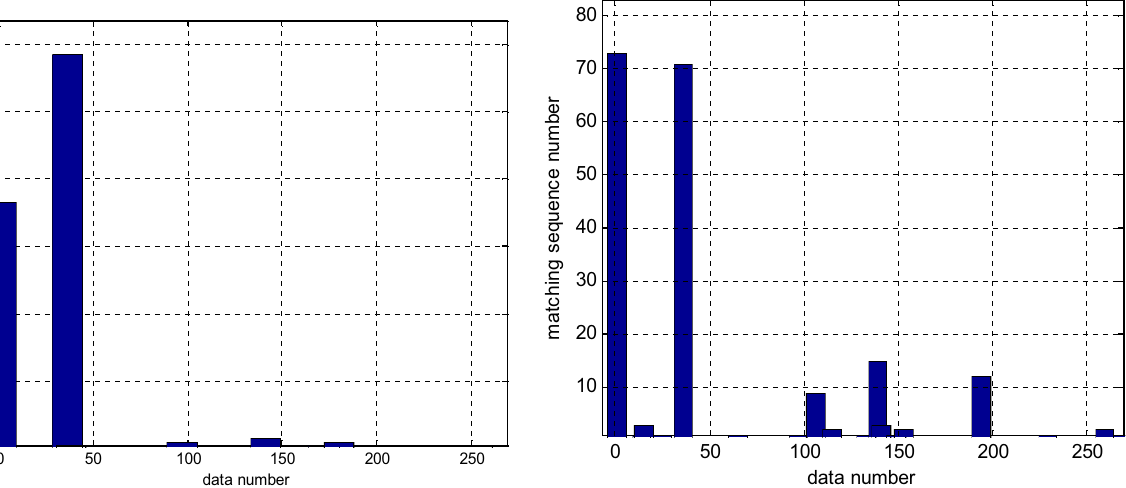
Figure 11: Identi fi cation results of matching sequence number fre - quency statistics based on fuzzy